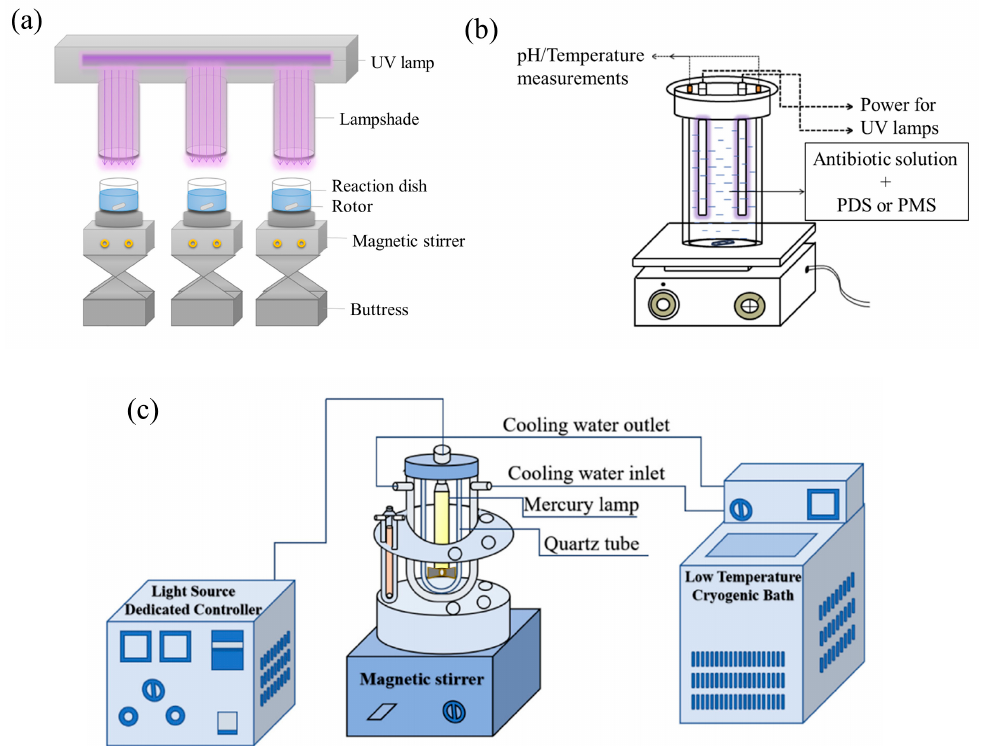
Figure 3. Several reactors for UV/PDS(PMS) in degrading antibiotics. ( a ) horizontal lamps [42]. Cop-